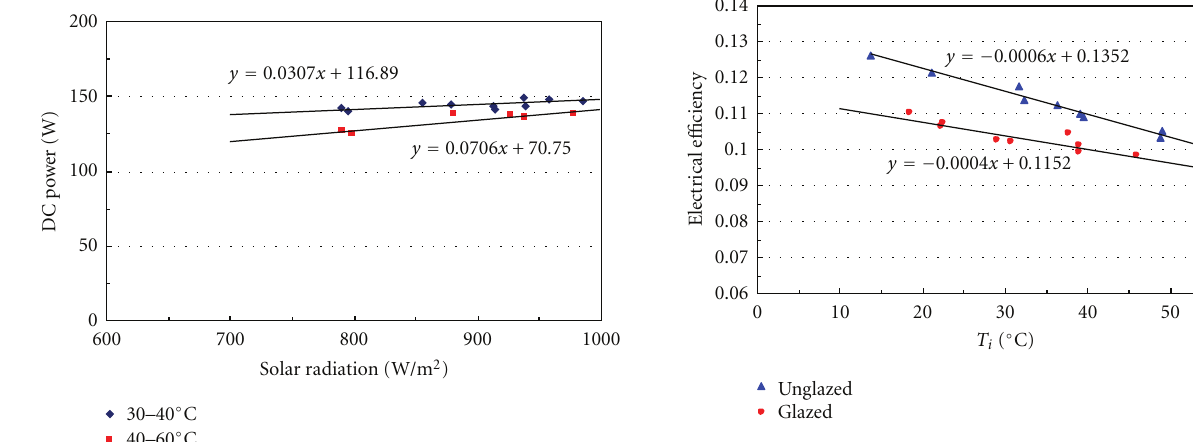
Figure 11: Electrical e ffi ciency of the glazed and unglazed PVT collectors as a function of fluid inlet temperature (solar radiation 950 W/m 2